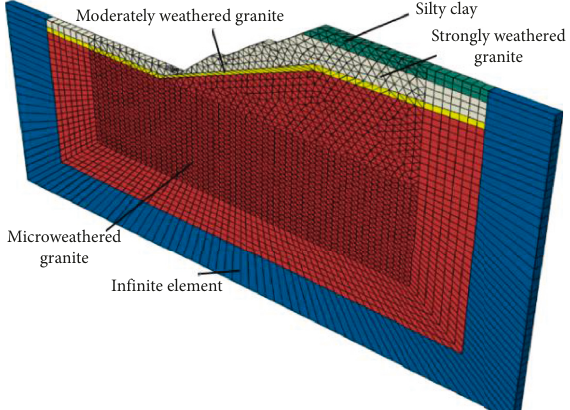
Figure 4: Finite element model of the bedding rock slope (different rocks in different